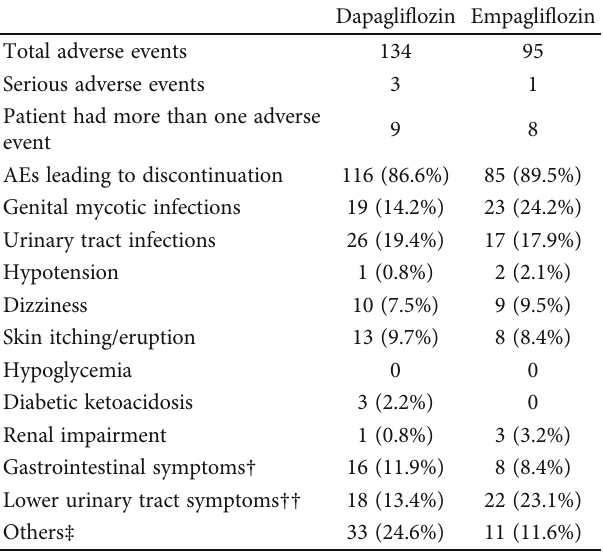
Table 5: Adverse events.